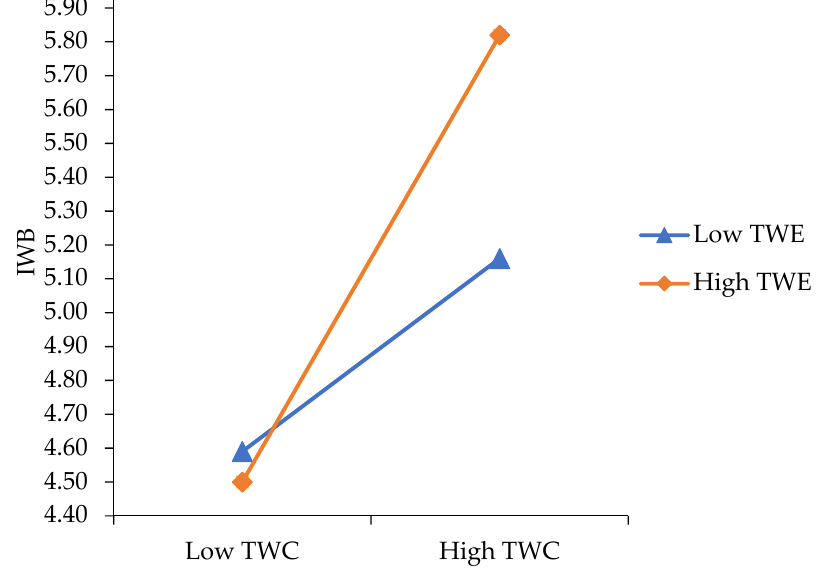
Figure 2. Relationship between TWC and IWB at low and high levels of TWE.